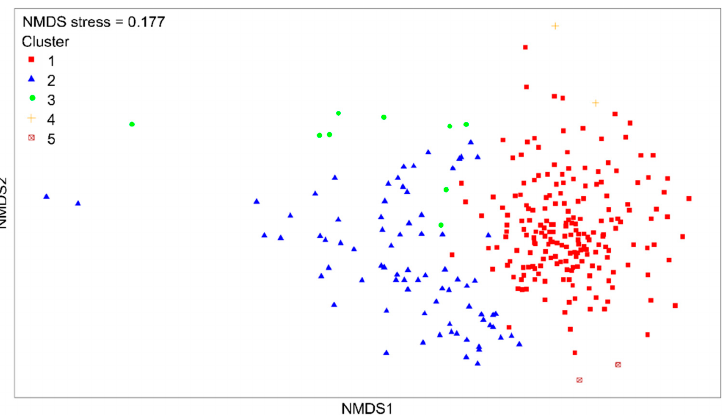
Figure 3. nMDS plot of multivariate Hellinger distance matrix of transformed morphospecies density data. Samples are coloured to represent the five clusters identified by hierarchal clustering analysis.